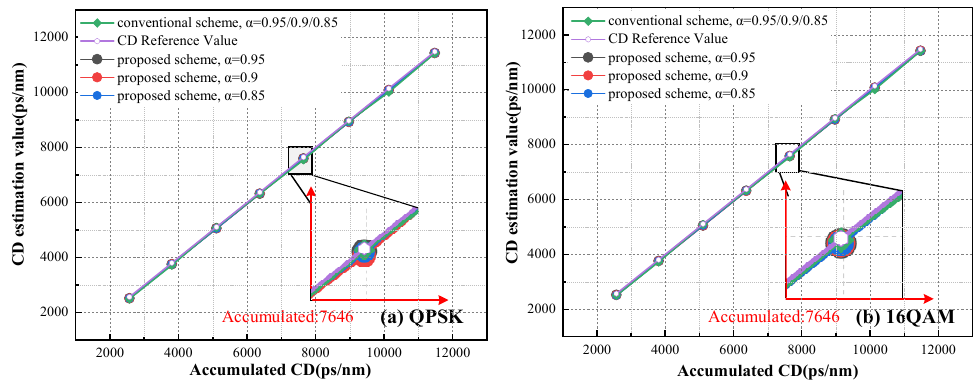
conventional scheme, α=0.95/0.9/0.85 CD Reference Value proposed scheme, α=0.95 proposed scheme, α=0.9